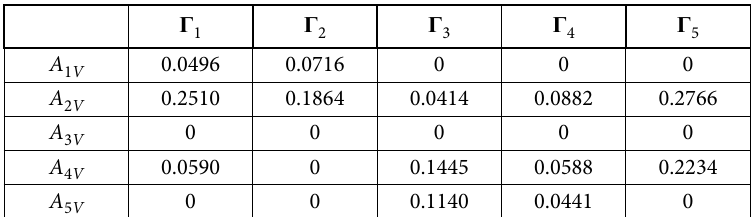
Table 5. The NDA of classical EDAS method